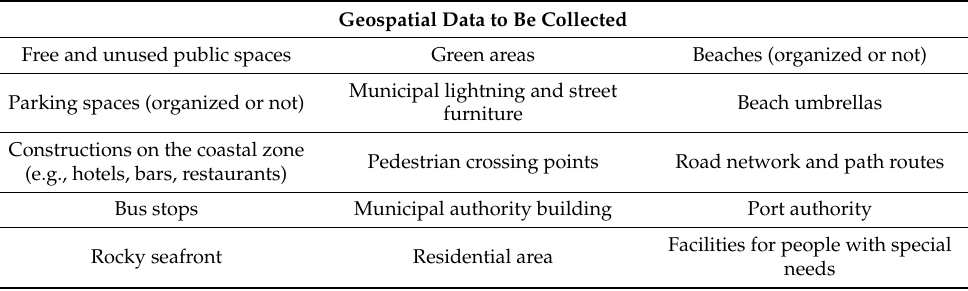
Table 1. Types of geospatial data to be collected. Geospatial Data to Be Collected Free and unused public spaces Green